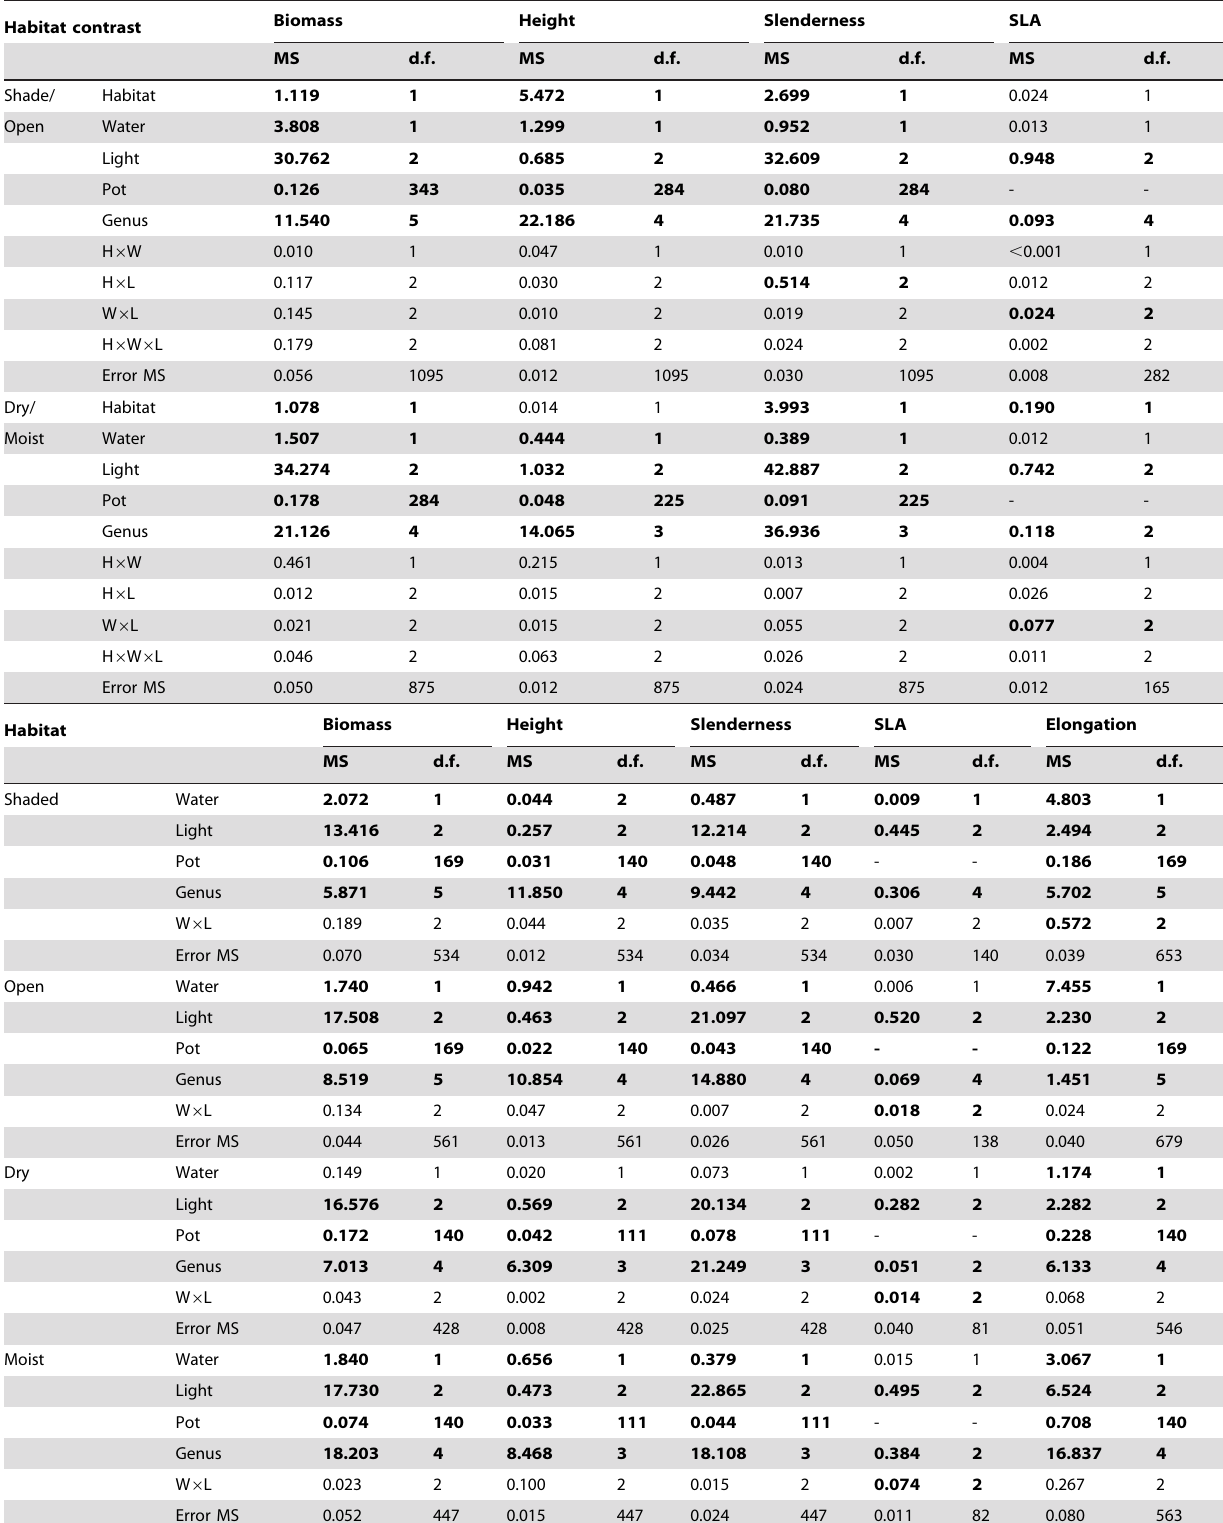
Habitat contrast Biomass